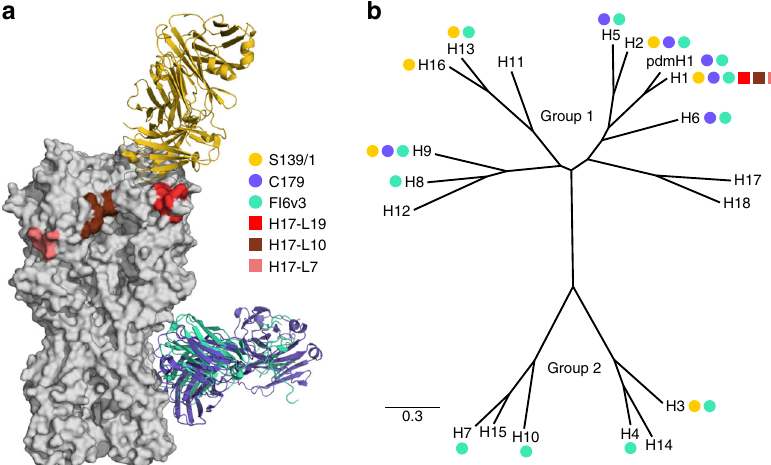
Fig. 2 Epitopes and breadth of broad and narrow antibodies targeting HA. a Crystal structures of the broad antibodies and sites of escape mutations selected by the narrow ones superimposed on the structure of the HA trimer (PDB 1RVX 77 ). S139/1 (PDB 4GMS 27 ) targets residues in the receptor- binding pocket; C179 (PDB 4HLZ 49 ) and FI6v3 (PDB 3ZTN 26 ) target the stalk. The sites of escape mutations for H17-L19, H17-L10, and H17-L7 are those mapped by Doud et al 47 . b A phylogenetic tree of HA subtypes. Circles (broad antibodies) and squares (narrow antibodies) denote reported antibody binding or neutralization activity against that subtype. Not all antibodies have been tested against all